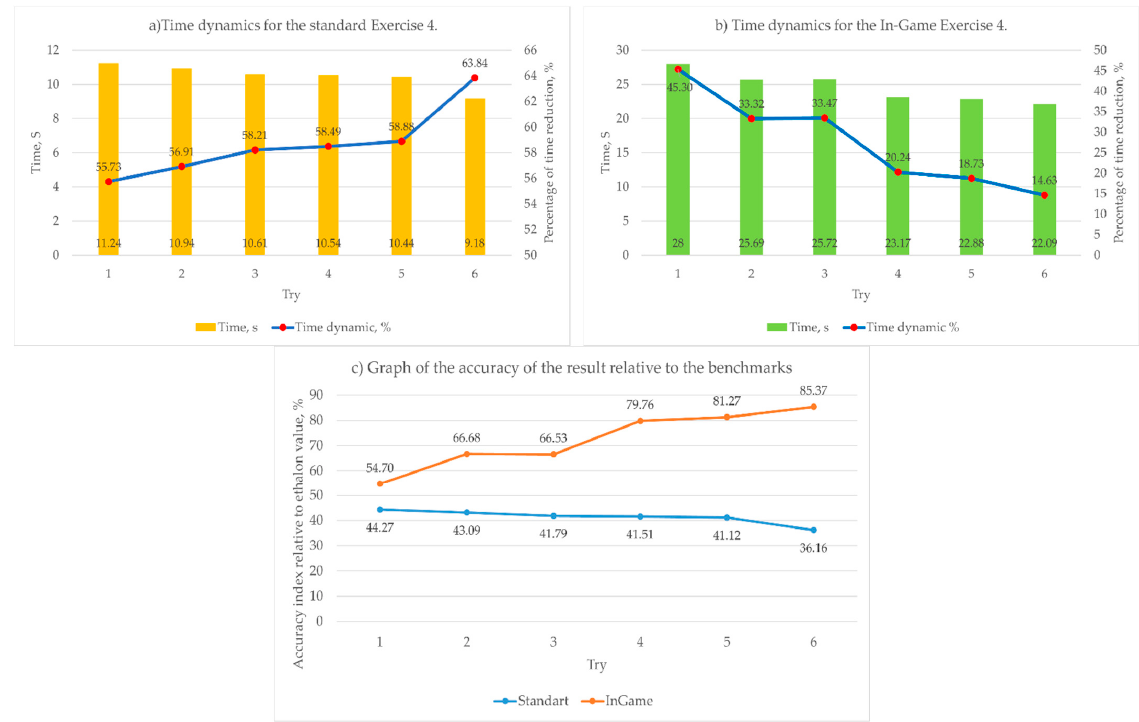
Figure 13. Comparison of both variations of Exercise 4. Where ( a )—characteristic of the change in the time result indicator for the usual form of Exercise 4, ( b )—characteristic of the change in the time result indicator for In-Game interpretation of the Exercise 4, ( c )—characteristic of the closeness of the obtained time to the etalon time in percent (higher is better).